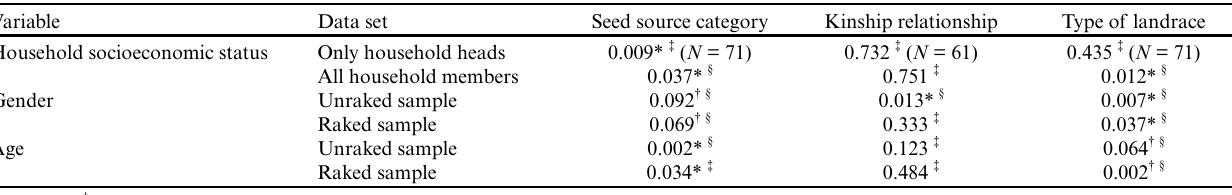
Table 3. Results of independence tests between farmer characteristics and properties of seed acquisition events. When considering all household members, N = 223 events. Market acquisitions are not considered in the kinship relationships variable ( N = 192). Variable